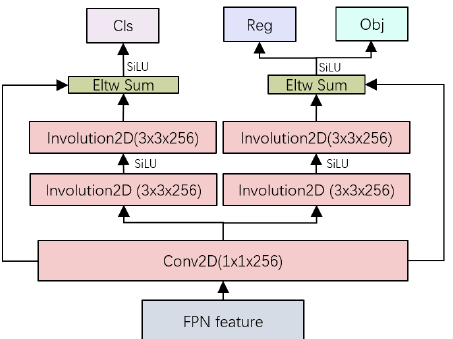
Figure 7. iResHead structure diagram. Cls is classification. Reg is regression. Obj is objection.